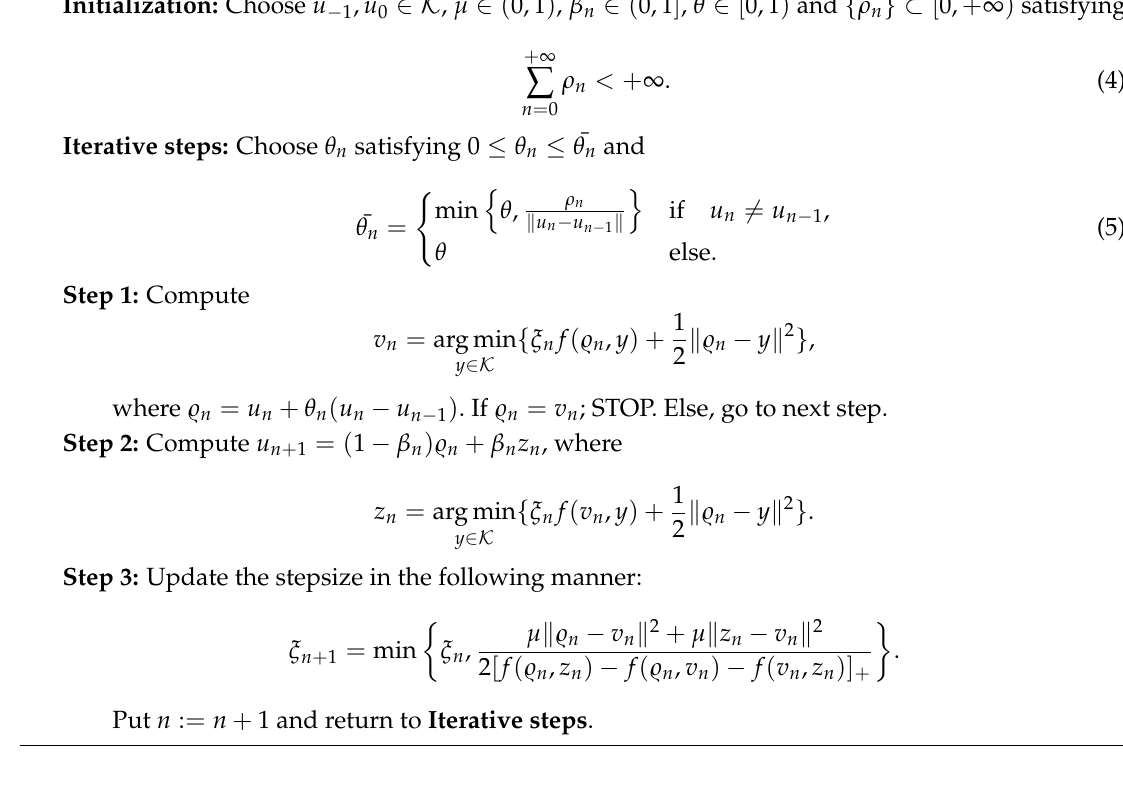
Algorithm 1 (Modified Extragradient Algorithm for the Problem